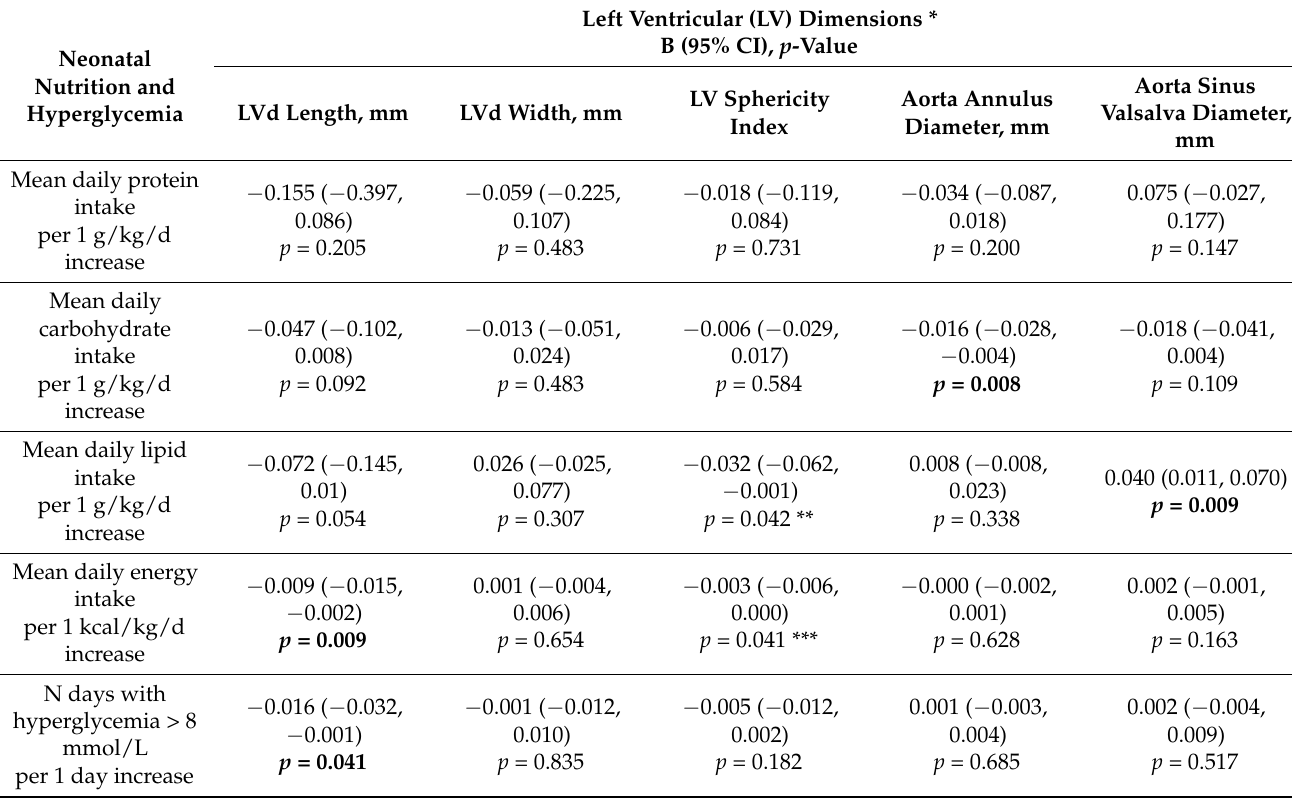
Table 4. Associations between macronutrient and energy intakes and hyperglycemia during the neonatal period with left ventricular dimensions at 6.5 years of age in children born extremely